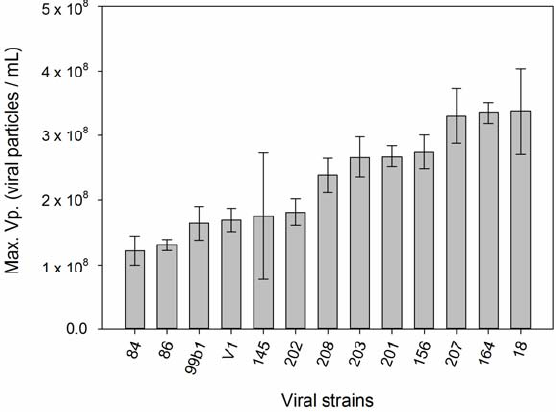
Figure 5. Differences between maximum viral production among EhV strains. Error bars show standard deviation ( n = 49).